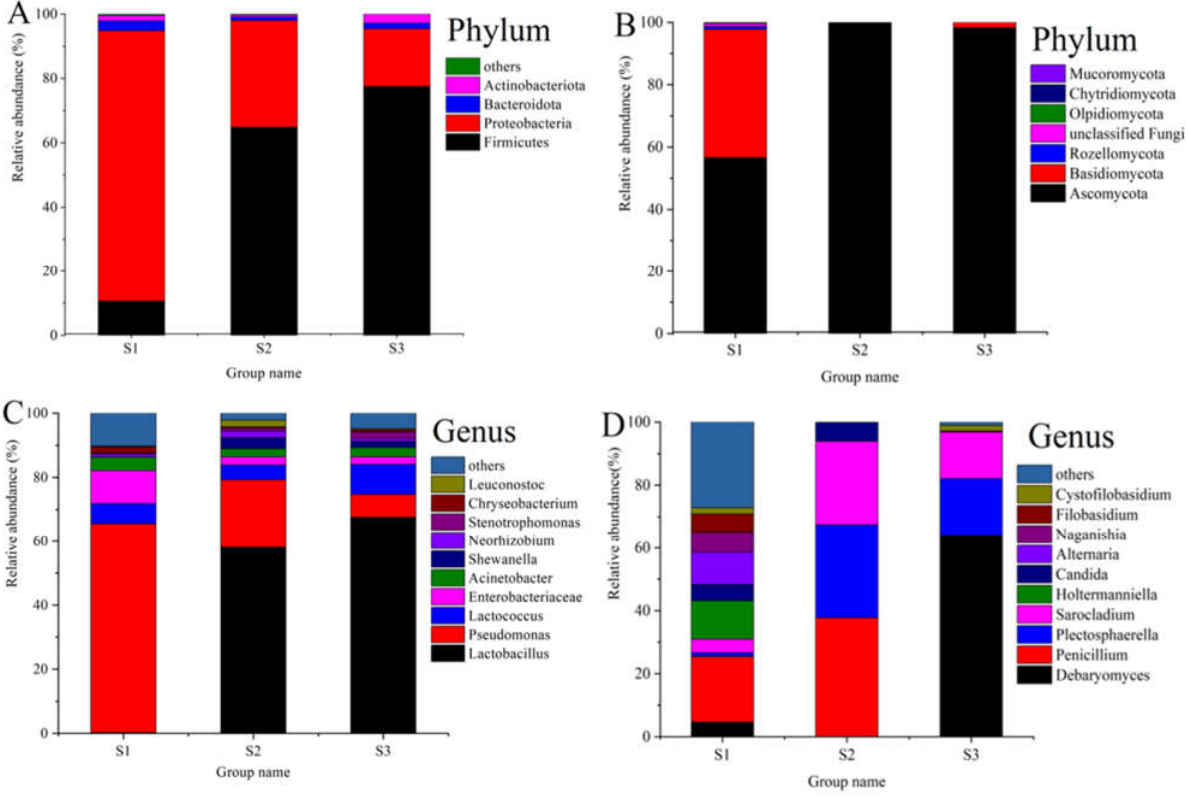
Figure 3. The relative abundance distribution of bacteria at phylum level ( A ) and genus level ( C ) and fungi at phylum level ( B ) and genus level ( D ) in fermented paocai.